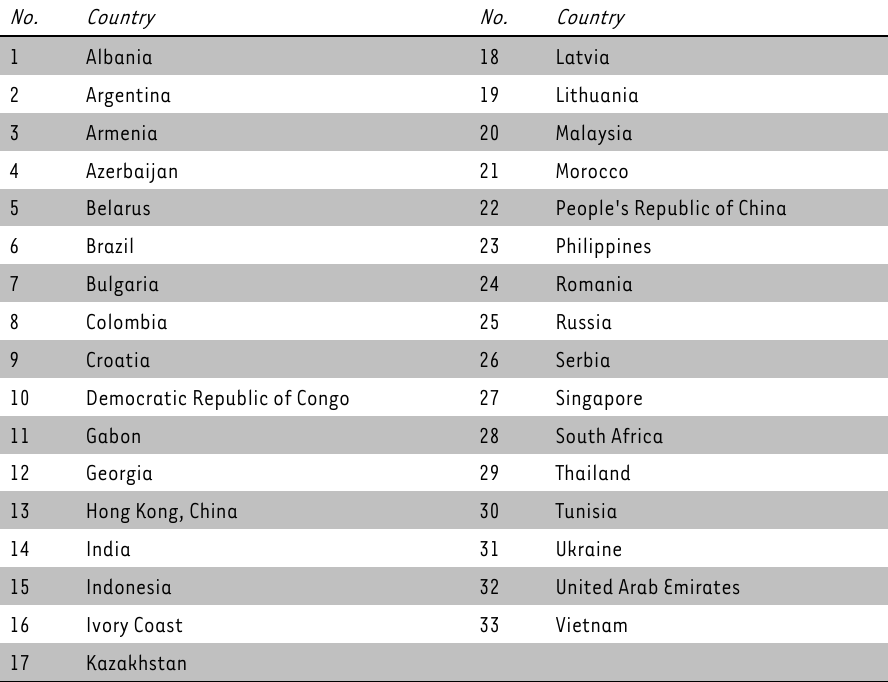
TABLE 2: Non-OECD countries whose positions are reflected in the OECD Model No. Country No.